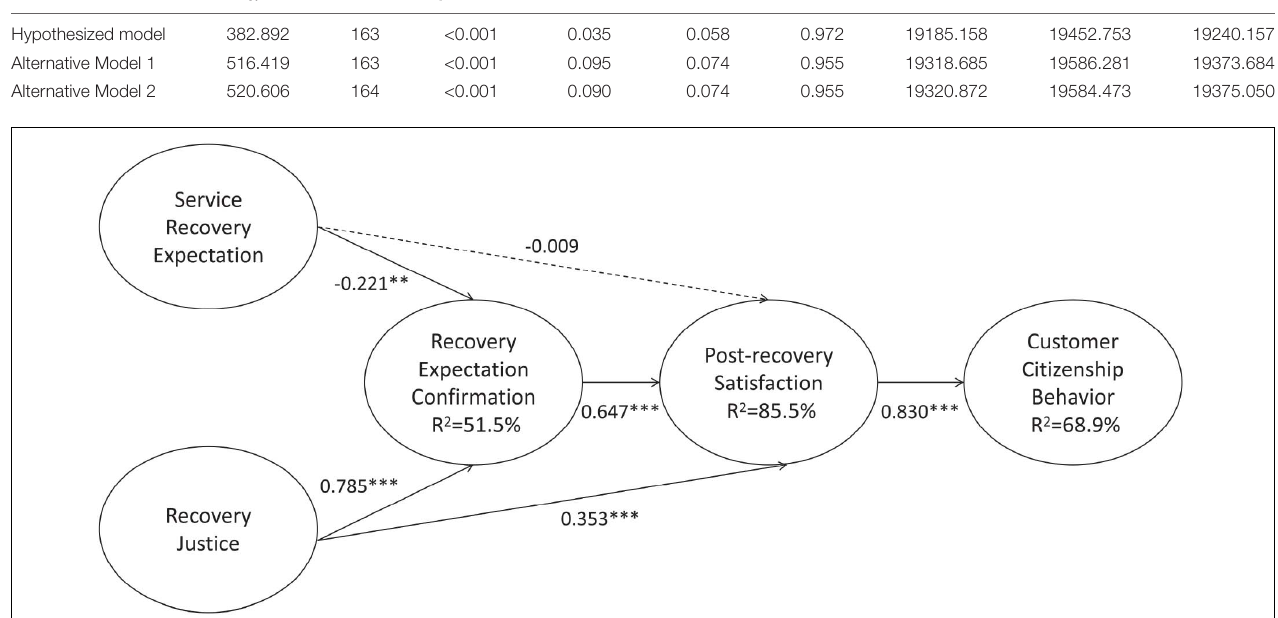
FIGURE 3 | Results of the hypothesized model (Based on the most recent service recovery experience). → , supported path; (cid:57)(cid:57)(cid:75) , unsupported path. ∗∗ p < 0.01, ∗∗∗ p < 0.001.